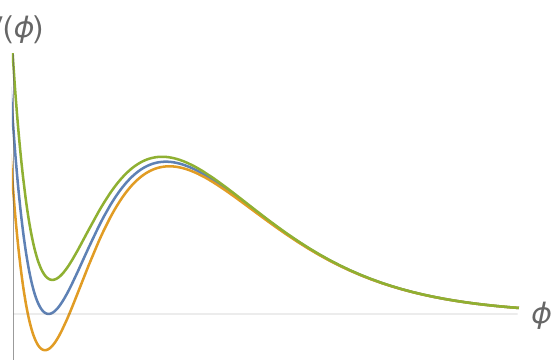
Figure 5. Potentials with (a) a metastable dS minimum (green), (b) a Minkowski minimum (blue), and (c) an AdS minimum (yellow). CdL tunneling rates from the asymptotic region to any of these minima vanish as the field rolls to